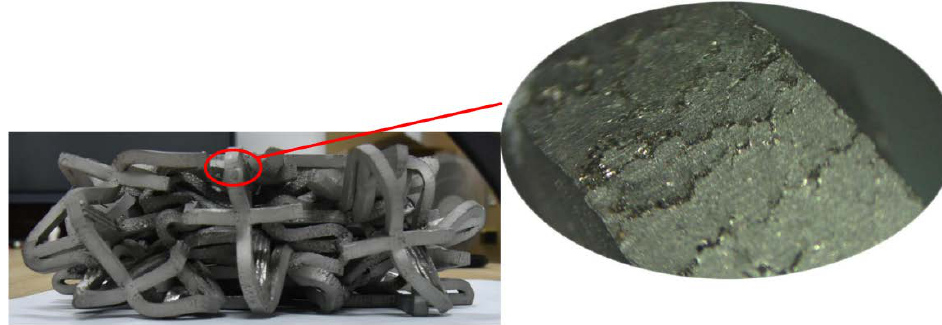
Figure 7. Local failure of lattice cracks.